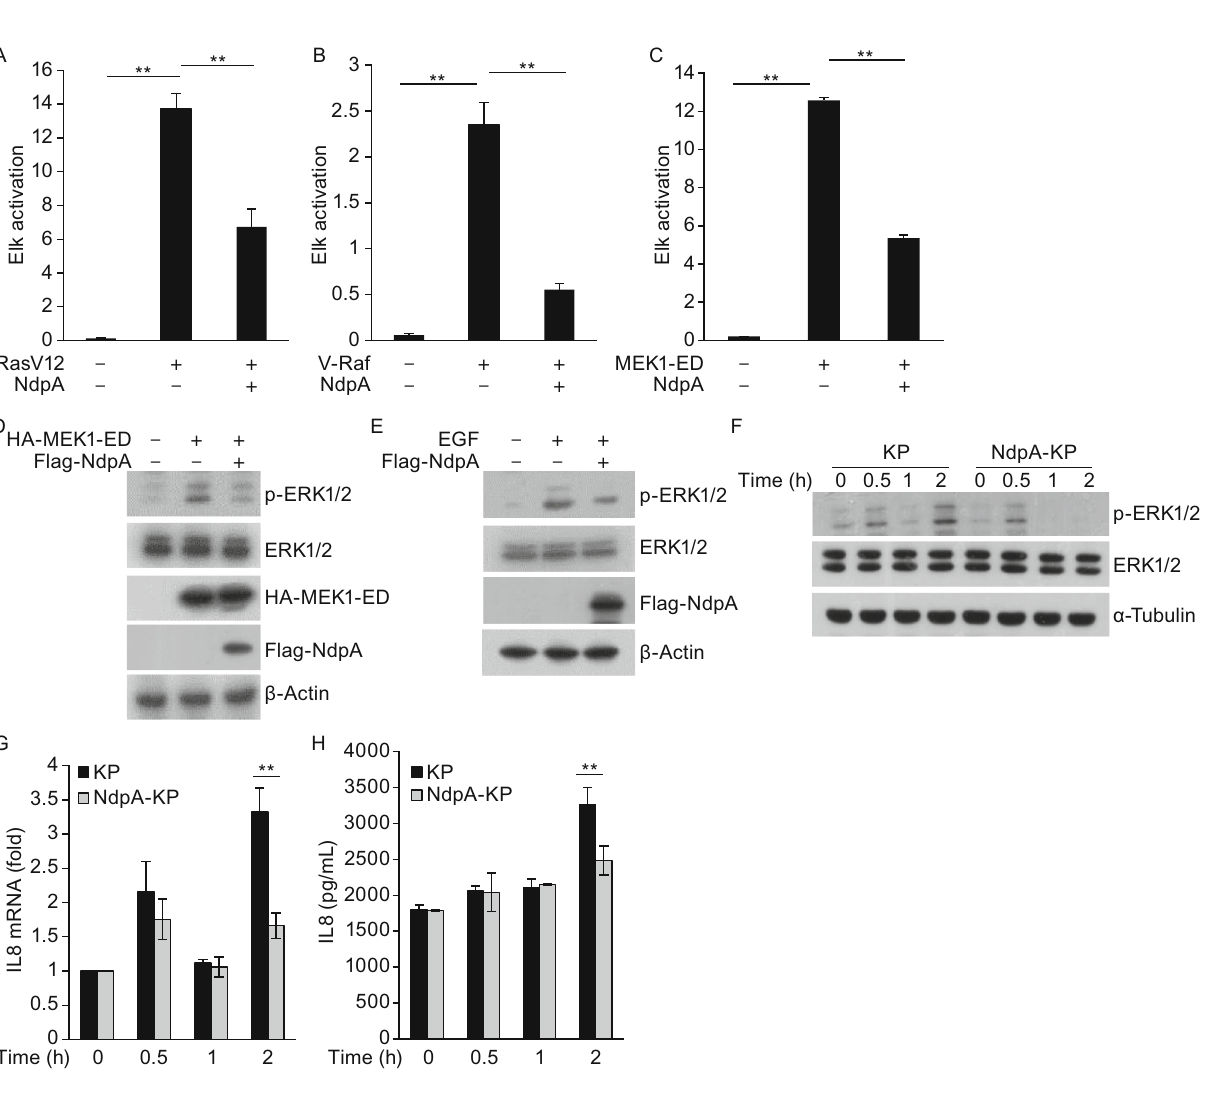
Figure 1. K . pneumoniae NdpA inhibits ERK1/2 signaling pathway activation. (A – C) Dual-luciferase assays of RasV12 (A)-, V-Raf (B)-, and MEK1-ED (C)- activated ERK1/2 signaling in the absence or presence of NdpA. Data are representative of at least three independent experiments (mean and SEM). * P < 0.05, ** P < 0.01 (two-tailed unpaired t -test). (D – F) The effects of NdpA on ERK1/2 phosphorylation as assessed by immunoblotting. HEK293Tcells expressing MEK1-ED without or with NdpA (D); HEK293T cells transfected with empty vector or vector encoding fl ag-tagged NdpA were treated with 100 ng/mL of EGF for 15 min (E); A549 cells were infected with WTor NdpA-overexpressing K. pneumoniae (NdpA-KP) for indicated time (F). (G) Quantitative real-time PCR analysis of Il8 mRNA in A549 cells infected with KP or NdpA-KP for indicated time. (H) ELISA analysis of IL8 in the supernatants of A549 cells infected with KP or NdpA-KP for indicated time,